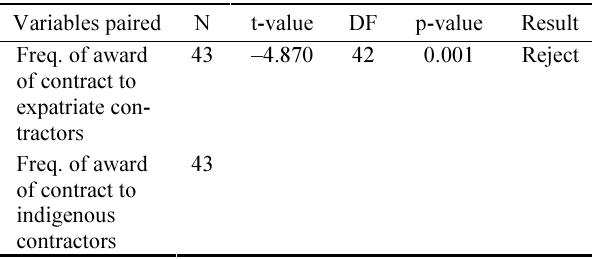
Table 2. Results of t-test for difference in the frequency of award of contracts to indigenous and expatriate con- tractors.